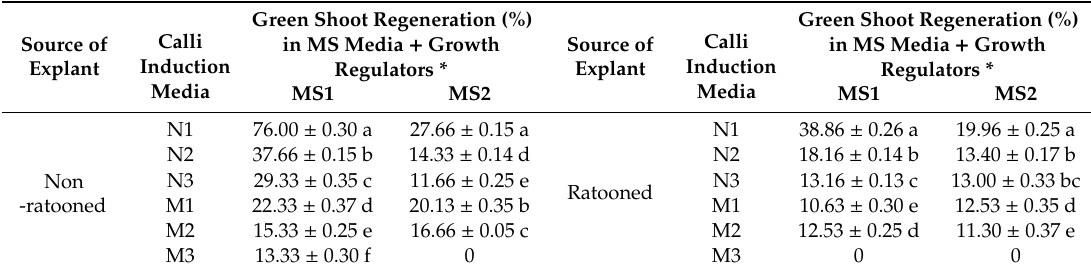
Table 2. Response of N6, MS media grown calli for shoot regeneration in MS media with growth regulators derived from anthers of non-ratooned and ratooned of